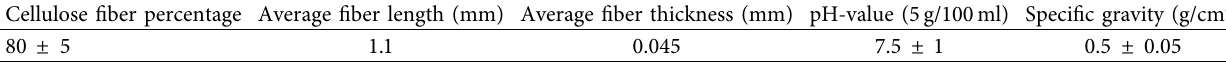
Table 9: The properties of cellulose fibers